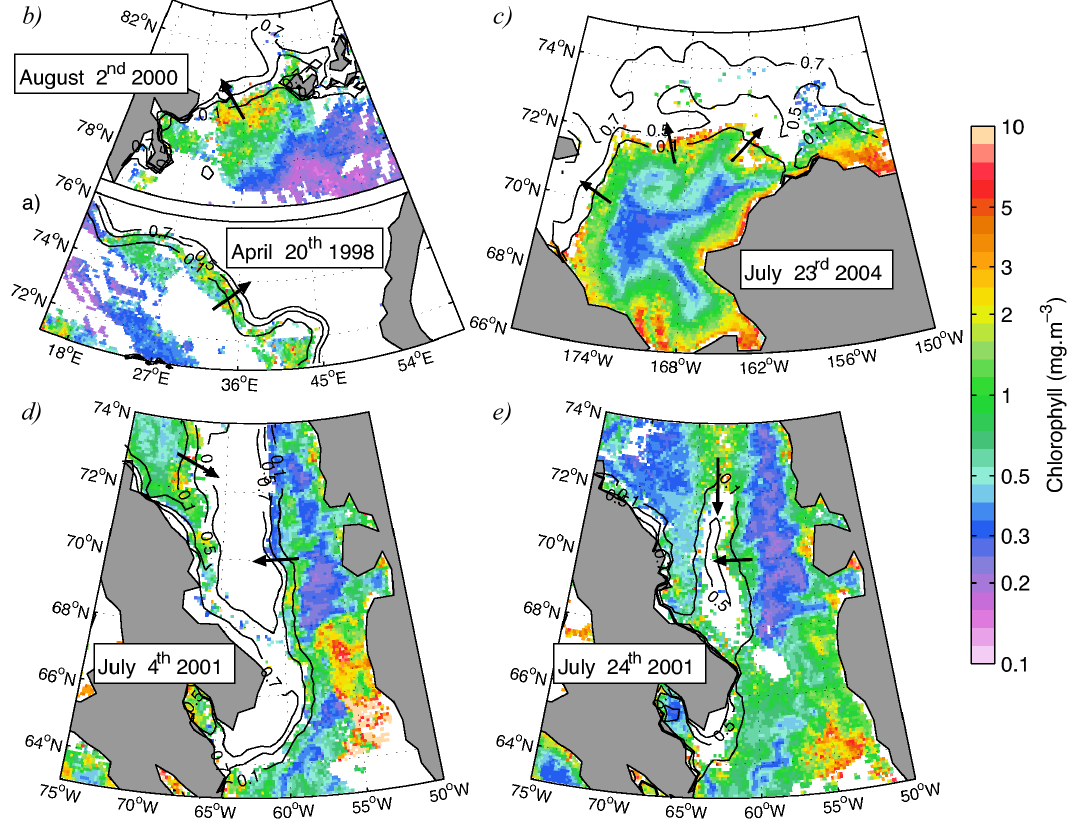
Fig. 2. Examples of ice-edge phytoplankton blooms and their evolution in different marginal seas of the Arctic. Barents Sea in (a) April 1998 (71–75 ◦ N) and (b) August 2000 (79–81 ◦ N). (c) Chukchi Sea in July 2004. (d, e) Davis Strait and Baffin Bay in July 2001 showing the change that occurs in 20 days. All images are 5-day composites of chlorophyll (SeaWiFS) overlaid with sea-ice contours (NSIDC) at 10%, 50% and 70%. White areas are missing chlorophyll data. Arrows indicate the propagation direction of the ice-edge, and hence of the